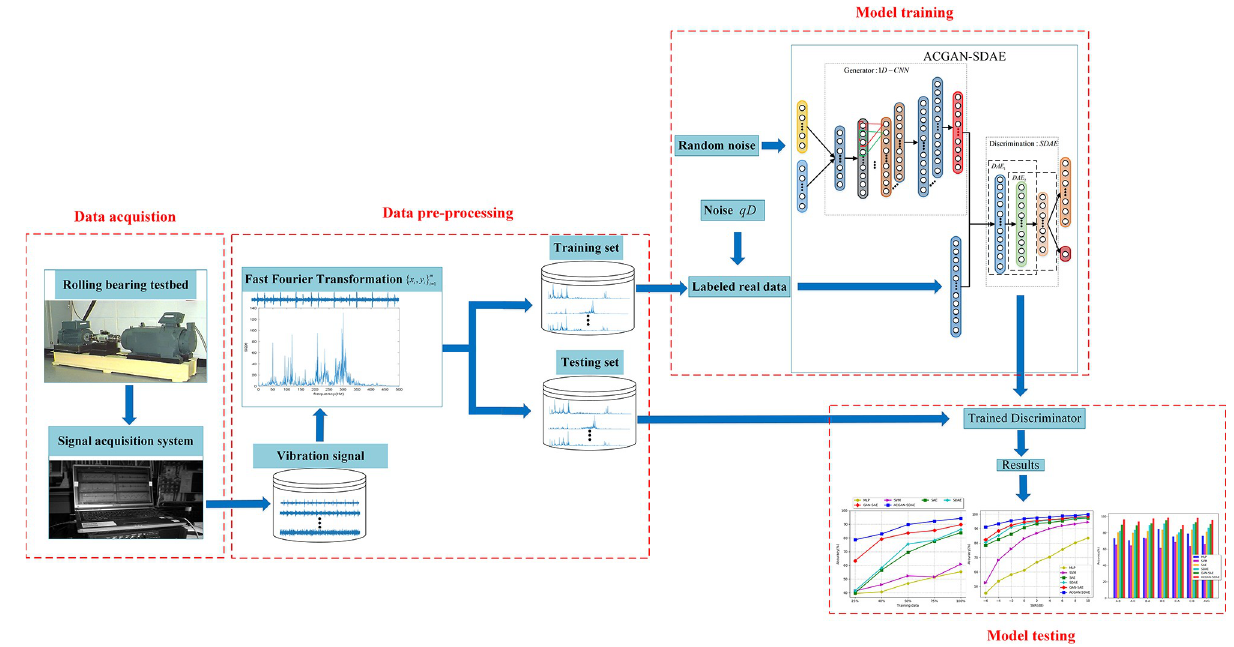
Fig 4. The overall architecture of ACGAN-SDAE fault diagnosis